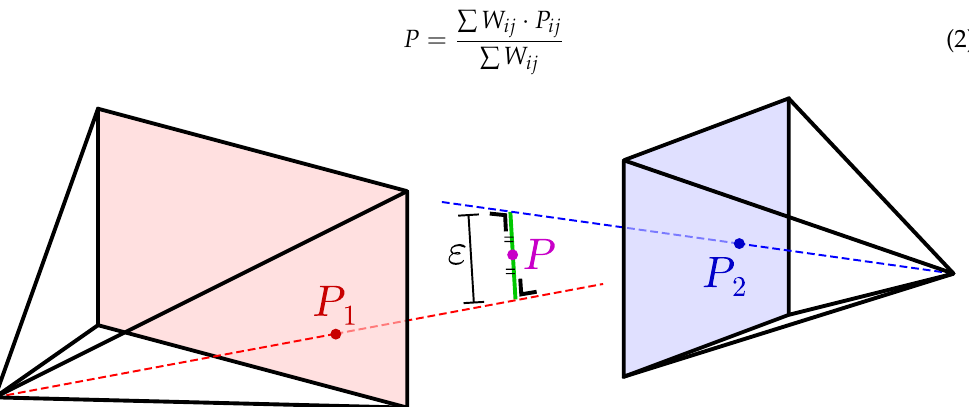
Figure 3. Illustration of the triangulation method for a single